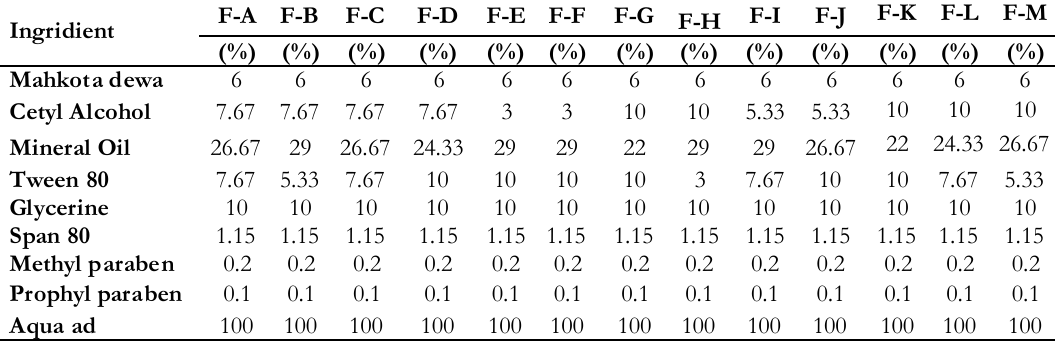
Table I. Composition and concentration of the optimum formula of o/w cream